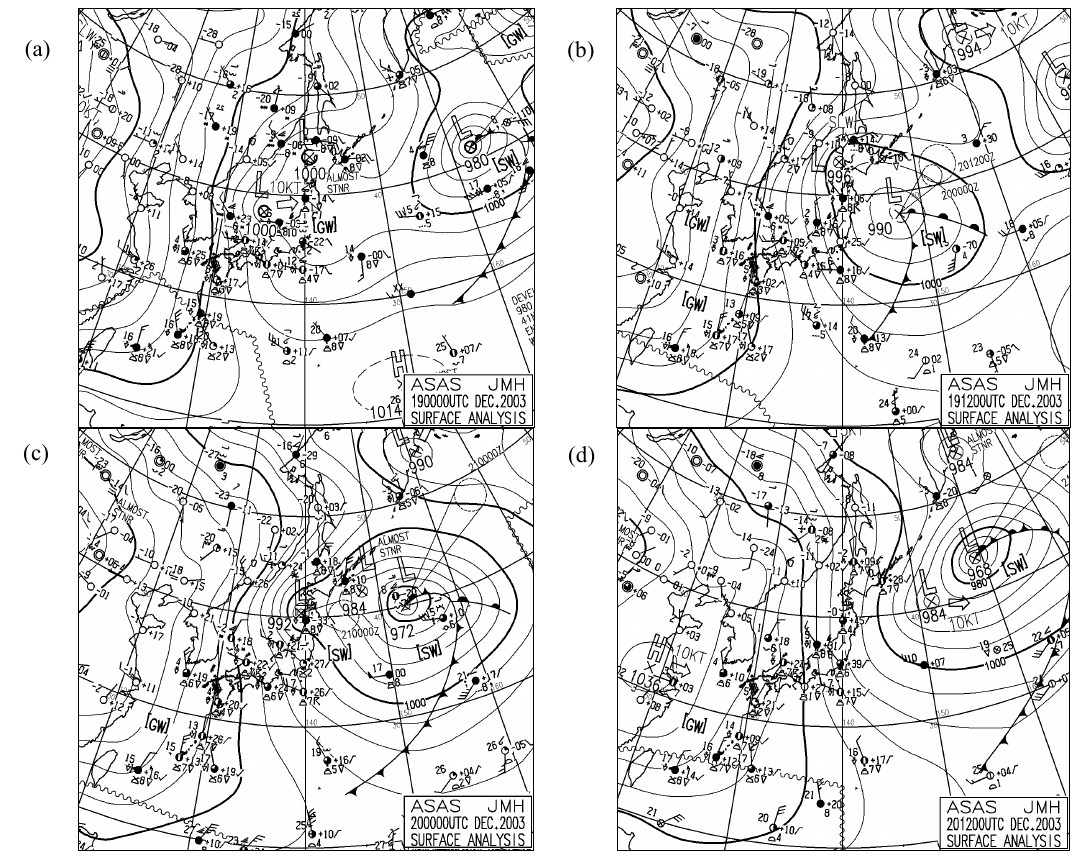
Fig. 1. Weather charts for 12 hour increments from 00:00 UTC 19 December to 12:00 UTC 20 December 2003 (from JMA).